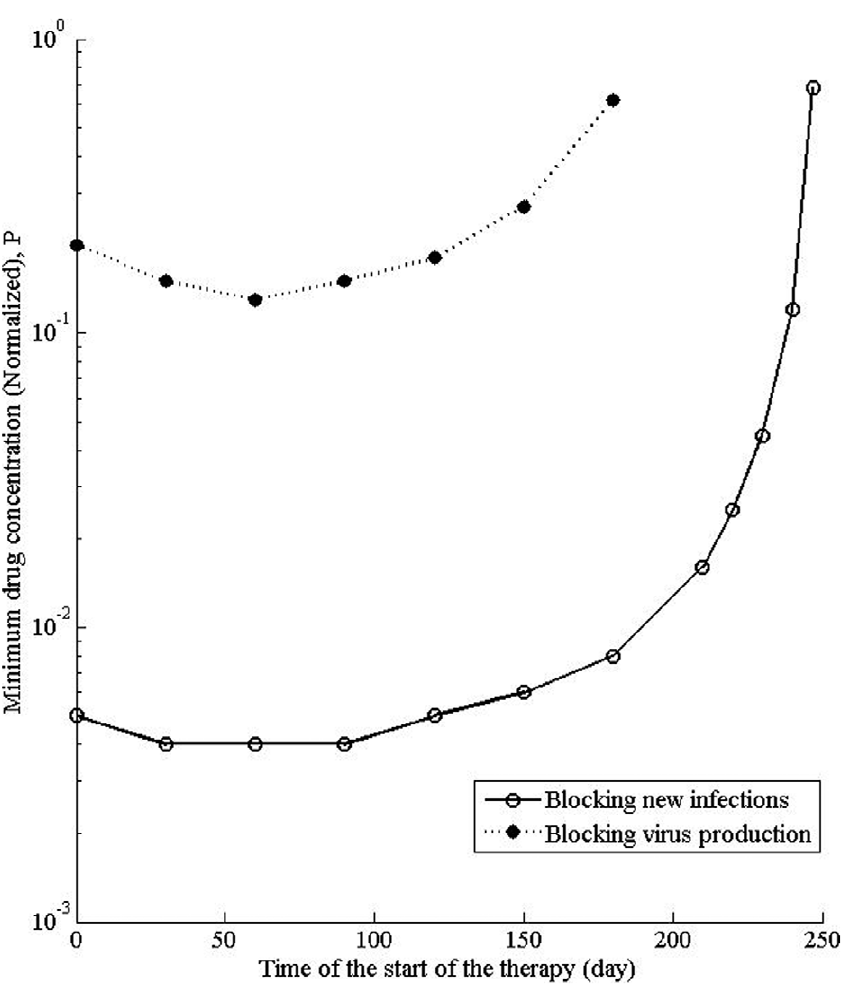
Figure 6. Effect of the time of start of the therapy on the state of the infection. The model has been perturbed for 180 days, starting at a specific day (x-axis) after the start of the infection. The minimum value of the normalized dose P, required to alter the steady state from ‘‘infected’’ to ‘‘uninfected’’ has been determined and plotted.